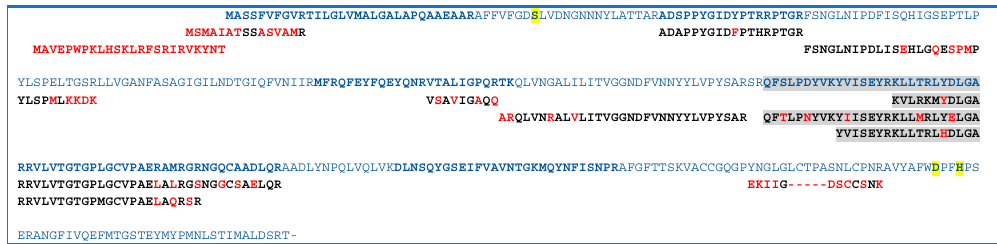
Figure 6. Sequence of GDSL from citrus by alignment of MS / MS validated peptides, using as reference sequence A0A067EBP6_CITSI (blue string). In bold is reported the validated sequences, in red is indicated the punctual modifications and in yellow is highlighted the catalytic triad, while the gray highlights the region with the major microheterogeneity of the protein.